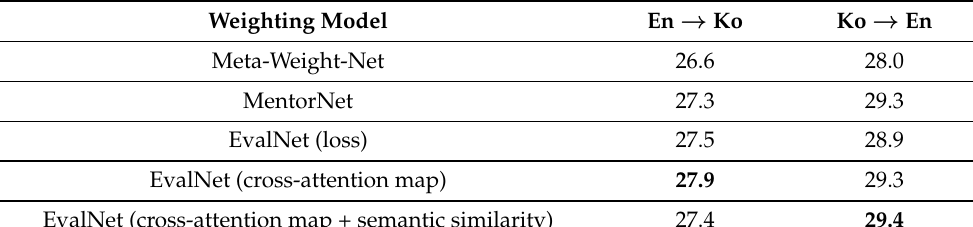
Table 7. Performance comparison with previous weighting